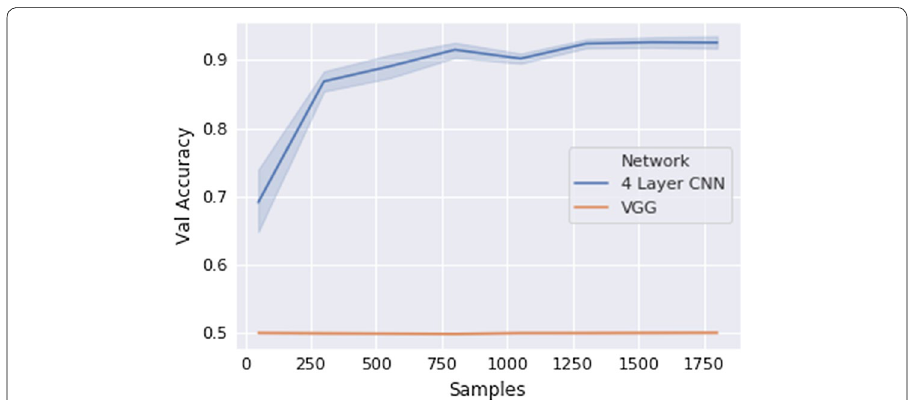
Fig. 2 Displayed above is the number of training samples from each category vs the validation set accuracy achieved by the corresponding model. For robustness, 10 trials were run for every amount of training samples tested. The color bands indicate the distribution of results from the 10